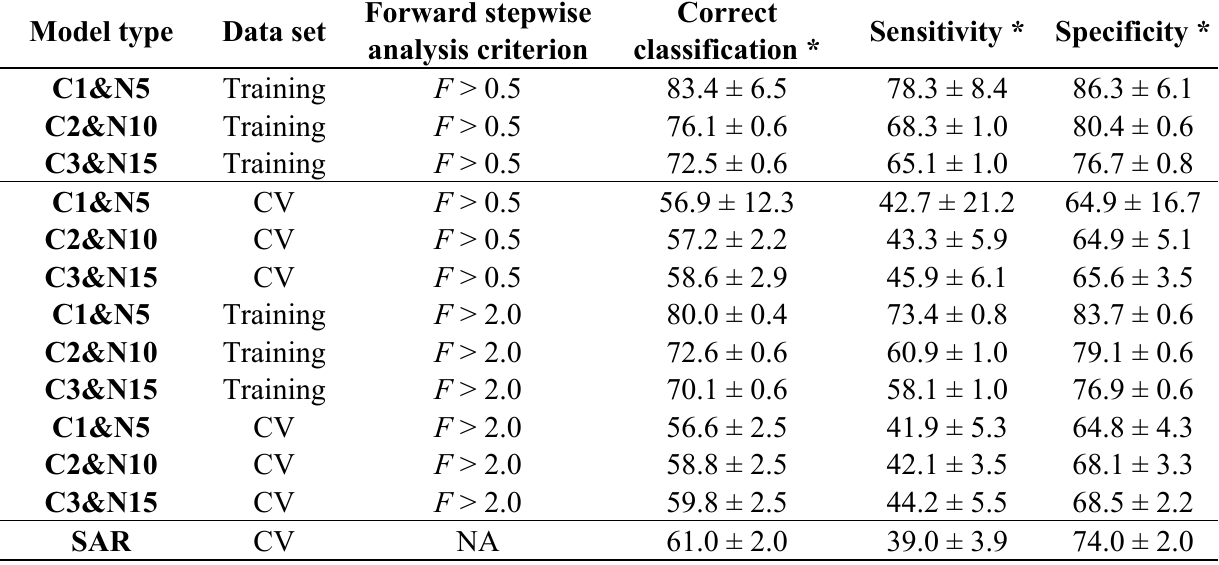
Table 1. Results of training and tenfold cross-validation for SDAR LDA and SAR DF models of inhibitors and non-inhibitors of CYP3A4.